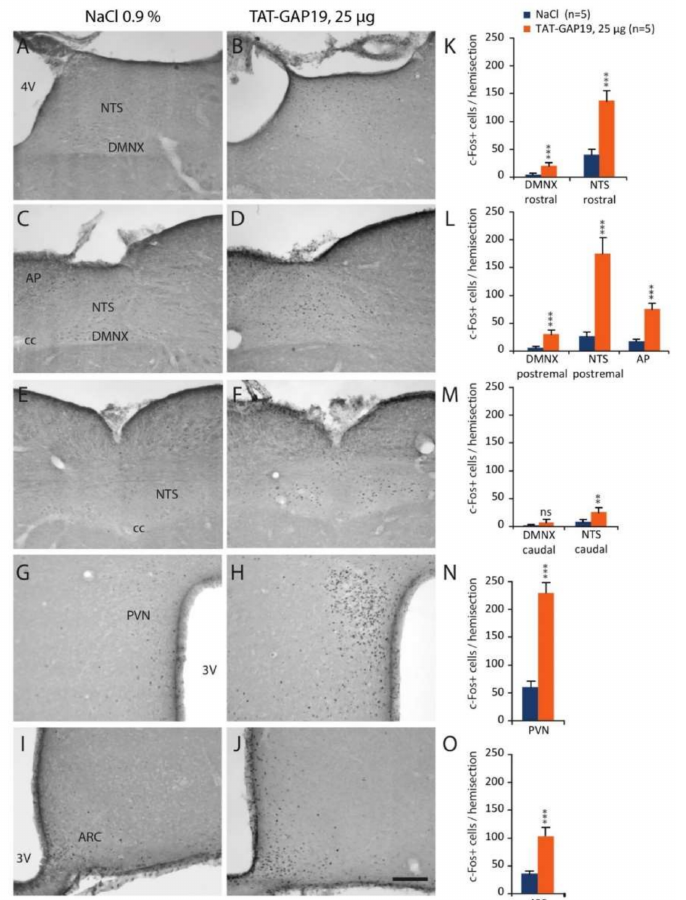
Figure 8. Microphotographs illustrating c-Fos protein immuno-labelling observed on coronal brain slices of mice treated with vehicle or TAT-GAP19 25 µ g and sacrificed 3 h after injection. In response to TAT-GAP19 injection, c-Fos positive nuclei were located within the rostral ( A , B ), postremal ( C , D ) and caudal ( E , F ) dorsal vagal complex (DVC), the PVN ( G , H ) and the ARC ( I , J ). Scale bar: 200 µ m. ( K – O ): Quantification of c-Fos positive cells in structures of interest for controls ( n = 5) and for mice treated with TAT-GAP19 25 µ g ( n = 5). PVN: paraventricular nucleus, 3V: third ventricle, ARC: arcuate nucleus, 4V: fourth ventricle, NTS: nucleus tractus solitarius, AP: area postrema, cc: central channel.